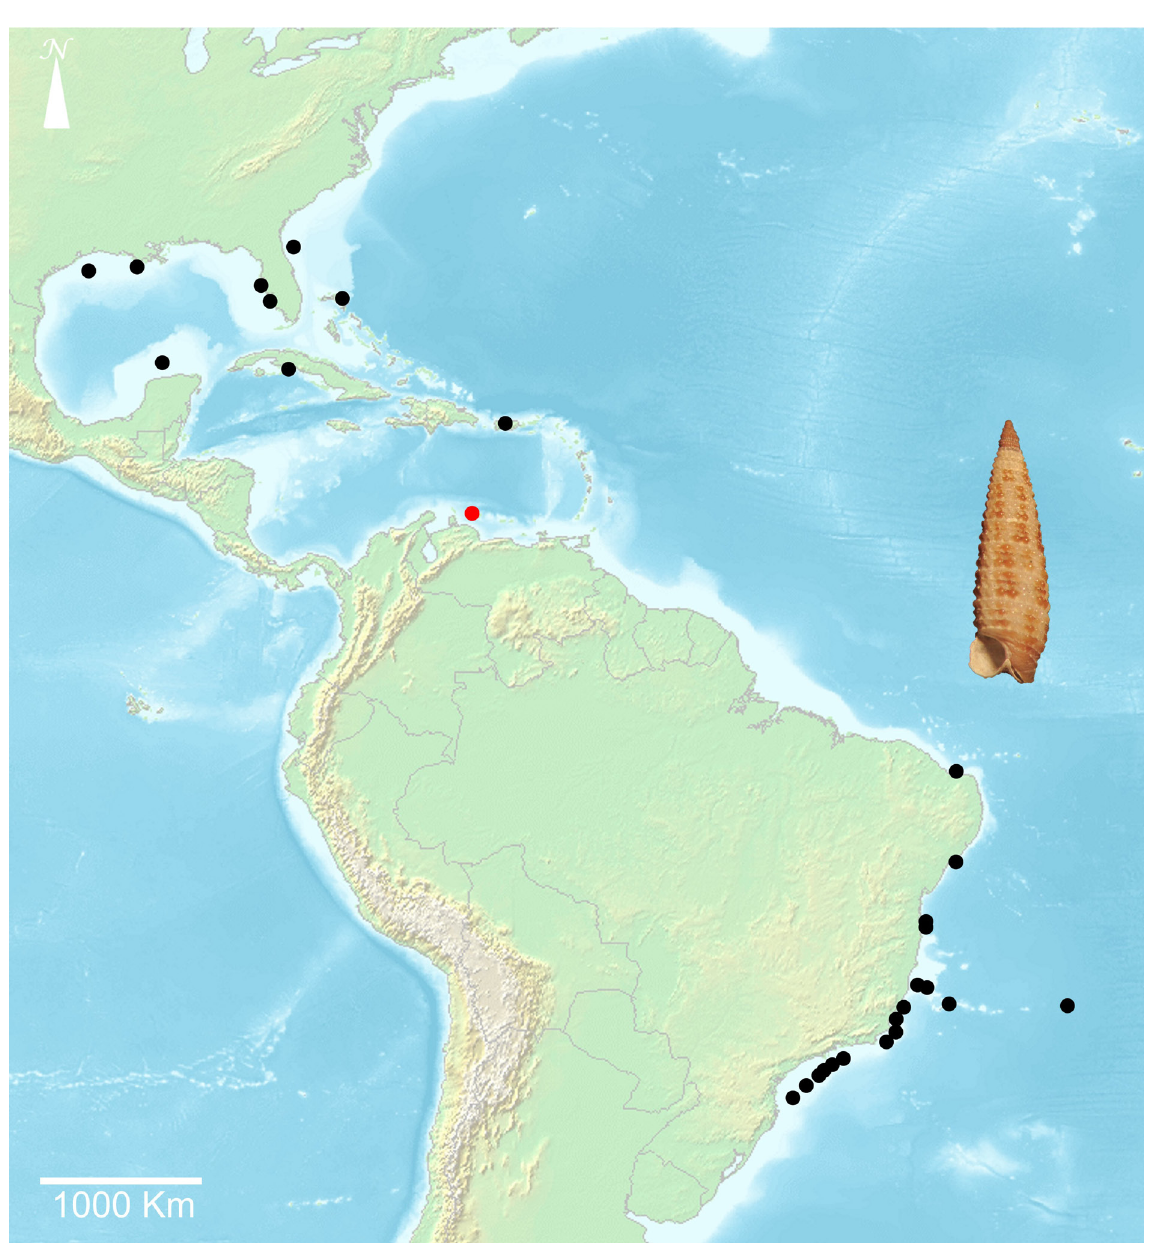
Fig. 31. Distribution map of Cosmotriphora arnoldoi Faber & Moolenbeek, 1991; red circle = type